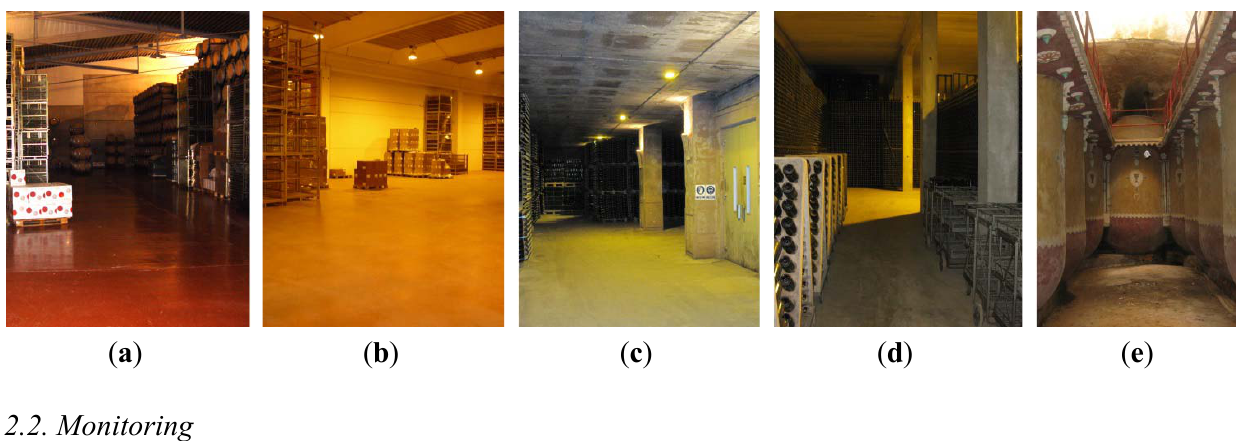
Figure 2. Interior of the selected warehouses: ( a ) aboveground without